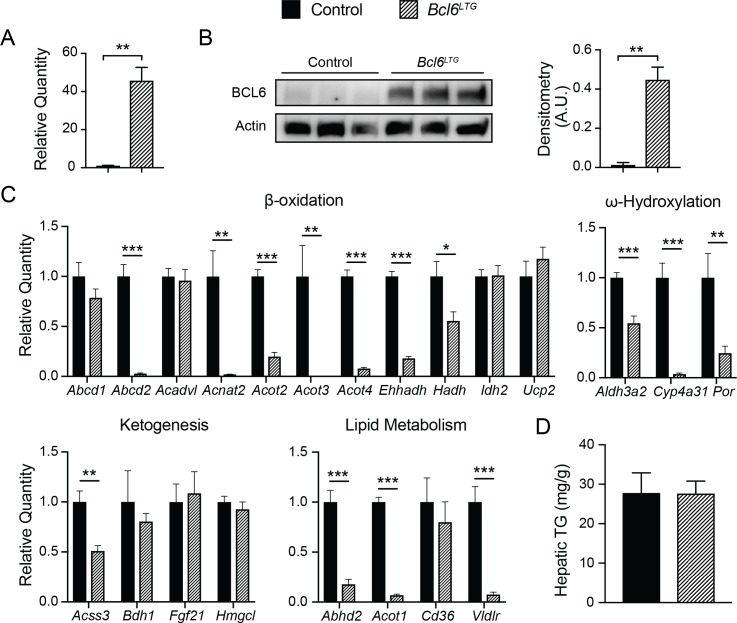
Overexpression of BCL6 downregulates fatty acid oxidation genes.(A) qPCR analysis of Bcl6 in control and Bcl6LTG livers. N = 3-7 per group. (B) Western blot of BCL6 protein in control and Bcl6LTG livers. Densitometric quantification is shown normalized to actin (right). (C) qPCR analysis of fatty acid oxidation and ketogenesis genes after a 48-hour fast. N = 6-7 per group. (D) Hepatic triglyceride content after a 48-hour fast. N = 67 per group. A two-tailed Student’s t-test assuming equal variance was used to compare mean values between groups. Data are represented as mean ± SEM. p < 0.05, p < 0.01, p < 0.001.